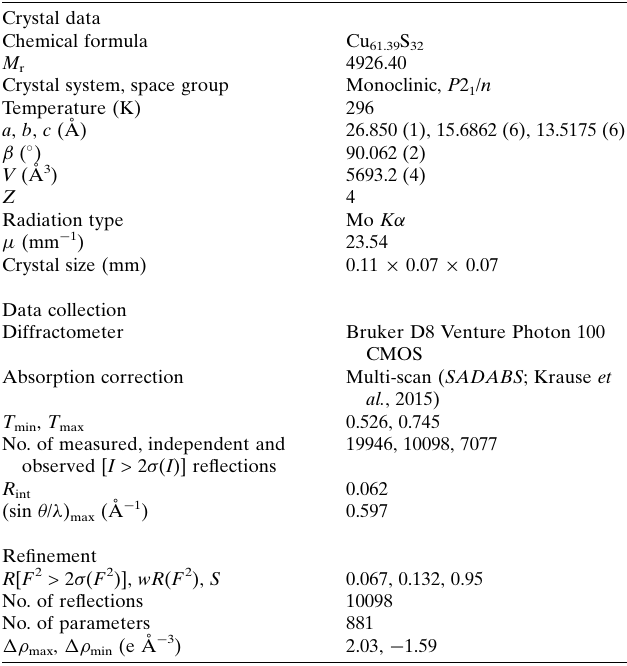
Table 1 Experimental